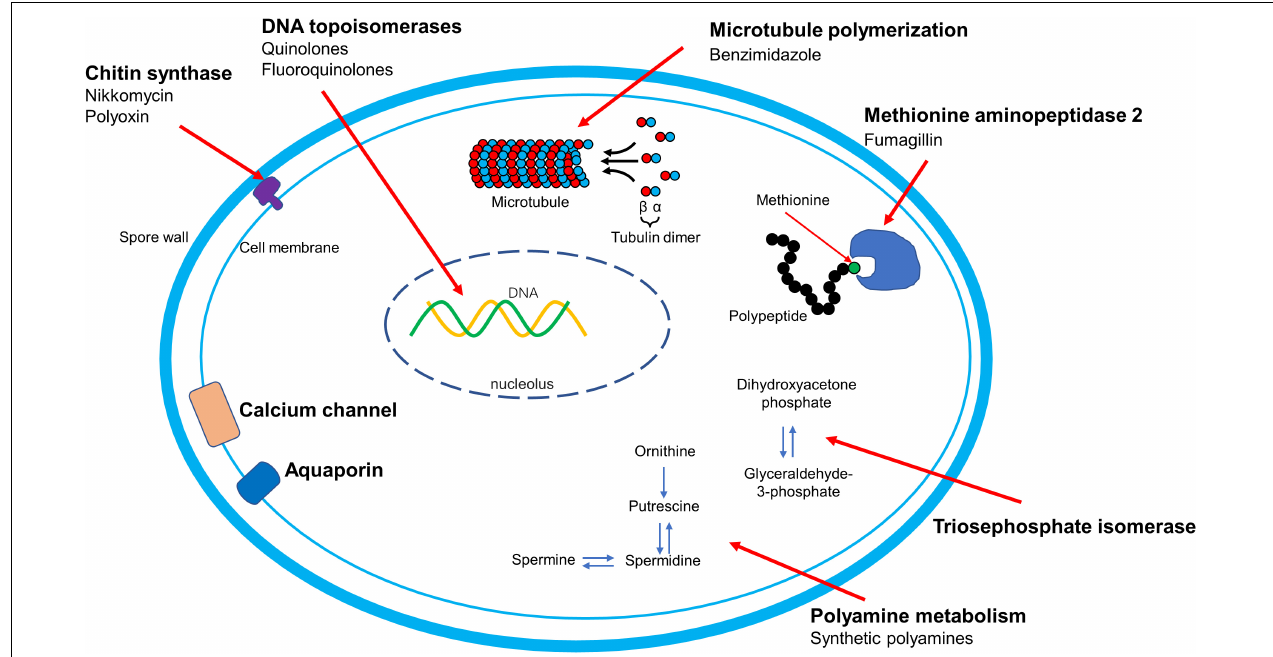
FIGURE 2 | | Mechanism of action of therapy and therapeutic targets for microsporidiosis. The names of therapeutic targets are presented in bold. The mode of action of orlistat and nitazoxanide are to be determined and are not shown in this